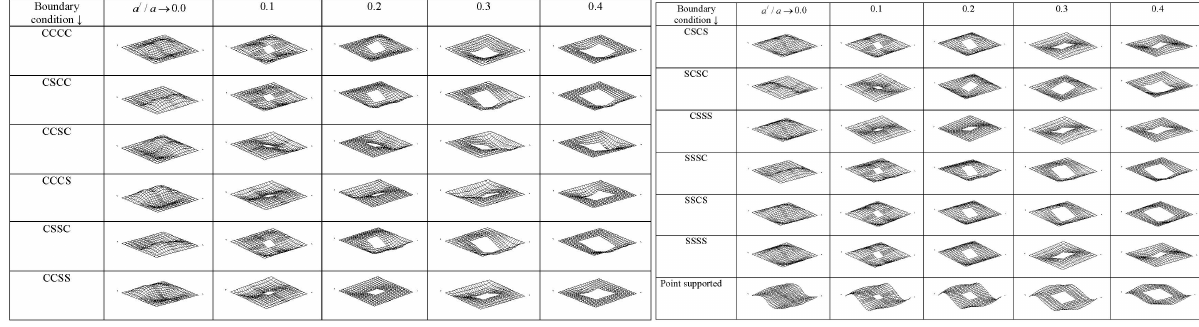
Figure 5: First mode shapes of laminated composite ( + 45/-45/ + 45/-45) stiffened elliptic parabolic shell for different sizes of the central square cutout and boundary